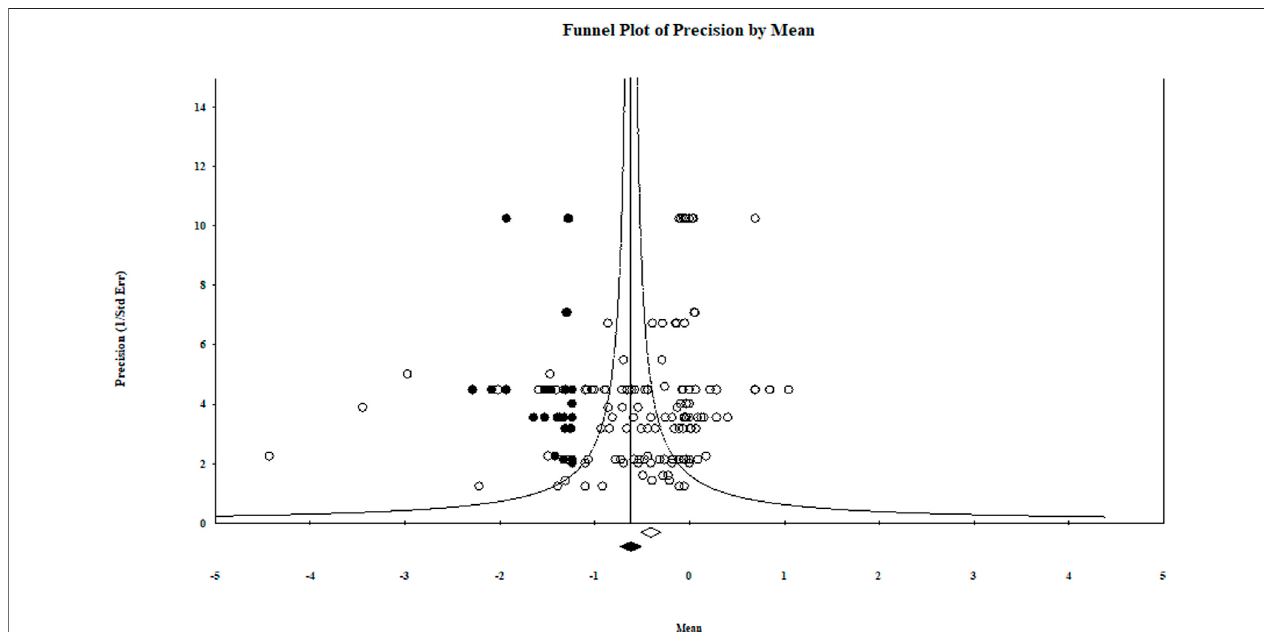
FIGURE 8 | Trim-and- fi ll plot for log response ratio showing asymmetrical distribution of studies about the combined effect size or mean (i.e., the new adjusted effectsize).Thisfunnelplotisameasureofstudysizeprecision(standarderror − 1 )ontheverticalaxisasafunctionofeffectsizeonthehorizontalaxis. Observedstudies; imputed